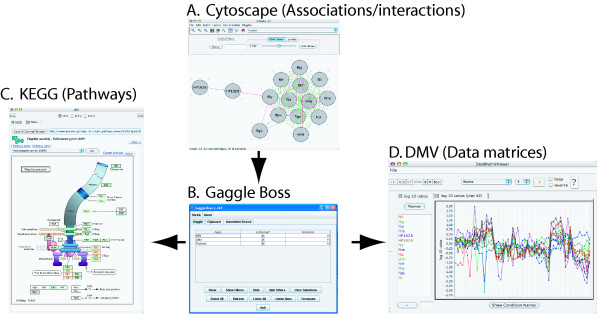
A simple introductory example for use of Gaggle. A set of genes (circular nodes with edges represents associations/interactions) selected in Cytoscape (A) are broadcasted to the Gaggle Boss (B). The Gaggle Boss re-routes the broadcast to a Java web browser connected to KEGG (C), further exploration wherein localizes H. pylori proteins to relevant subunits in the flagellar apparatus map. A second goose that receives the broadcast is the DMV (D). A plot function therein provides mRNA levels of the 15 H. pylori genes in 57 experimental conditions.